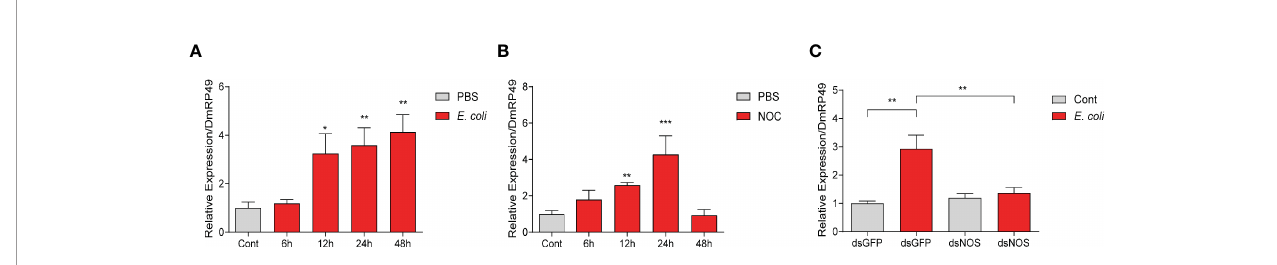
FIGURE 7 | NO contributed to the upregulation of CanA1 induced by killed E coli in Drosophila S2 cells. The expression pattern of CanA1 in response to E coli treatment (A) , NO donor (B) , and NOS knockdown followed by E coli treatment (C) was determined by qPCR. Cont: PBS treatment; NOC: Nitric oxide donor. One- way ANOVA followed by Tukey ’ s test was used to compare control and treated groups (A, B) . Student ’ s t-test was used to analyze signi fi cance (C) , * p < 0.05; ** p < 0.01; *** p < 0.001.